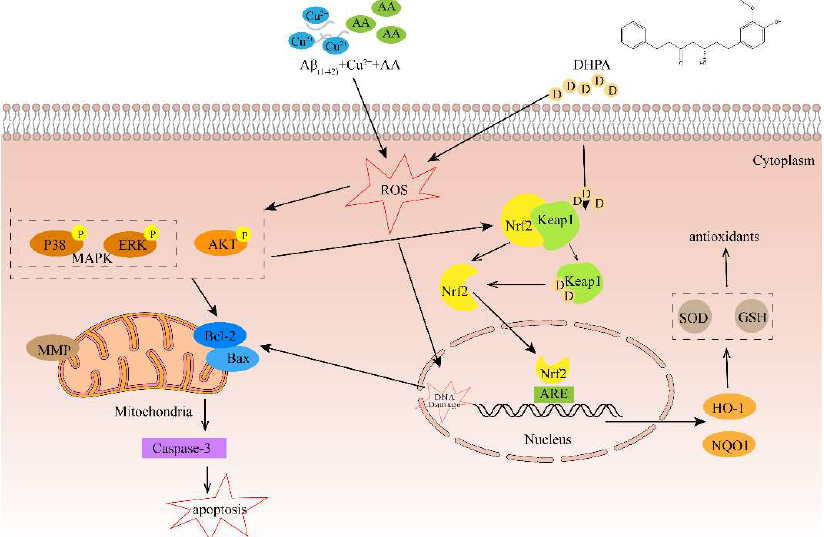
Figure 9. Schematic diagram of the mechanisms of DHPA protecting SH-SY5Y cells from apoptosis induced by Aβ (1 － 42) /Cu 2+ /AA.